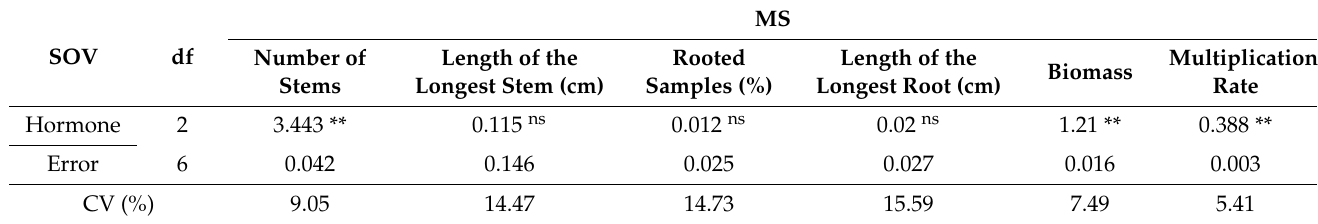
Table 2. Analysis of variance of plant growth hormones affecting S. pennata seedling growth charac- teristics on solid